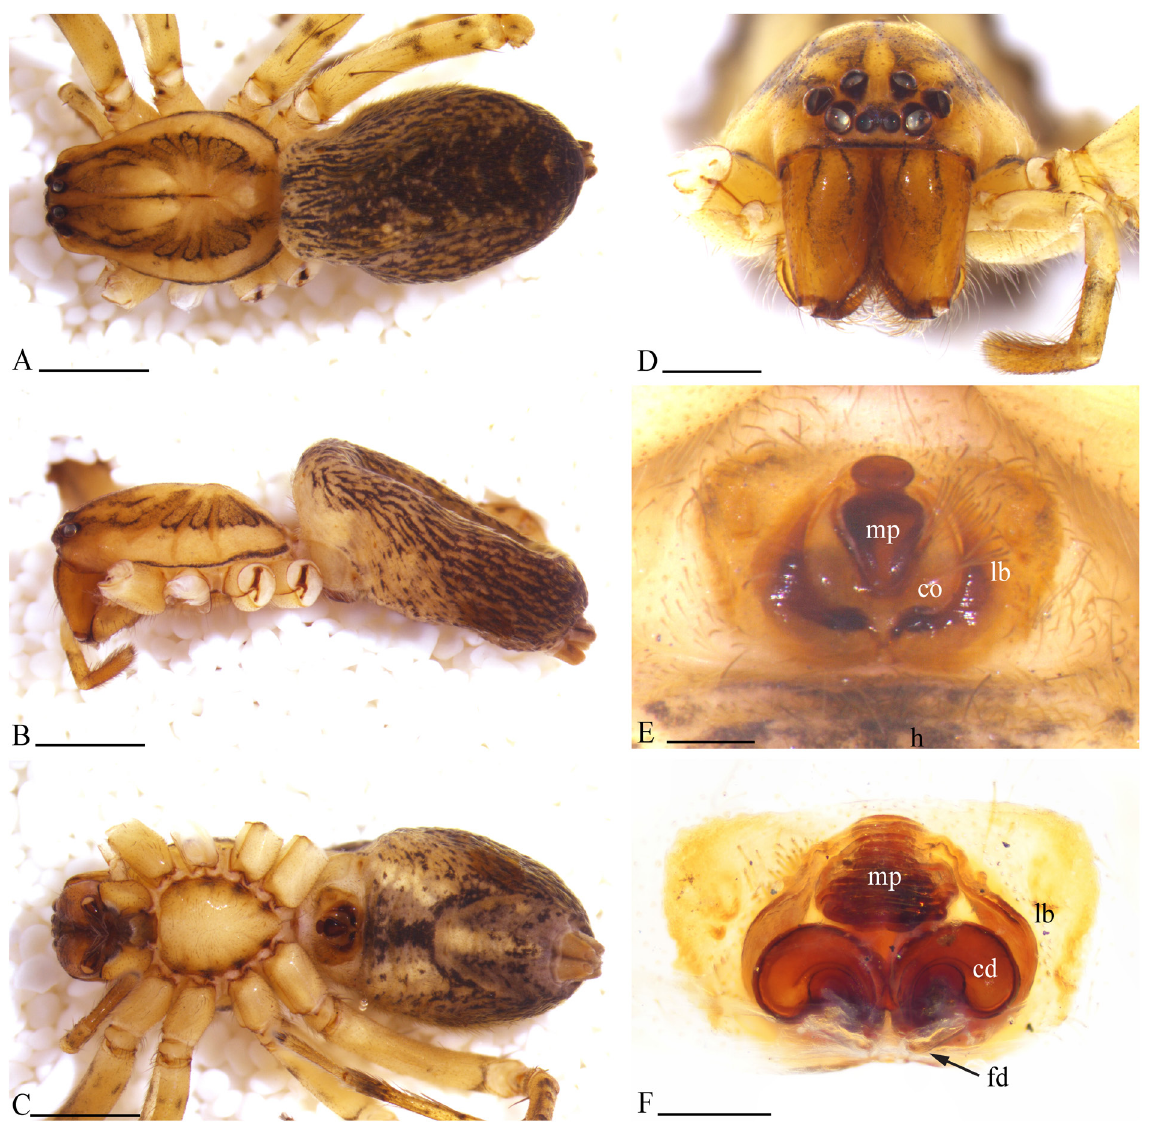
Fig. 9. Anyphaena fernandae sp. nov., holotype, ♀ (CNAN-T01526). A . Dorsal habitus. B . Lateral habitus. C . Ventral habitus. D . Prosoma, anterior view. E . Epigynum, ventral view. F . Epigynum, dorsal view. Scale bars: A–C = 1.0 mm; D = 0.5 mm; E–F = 0.2